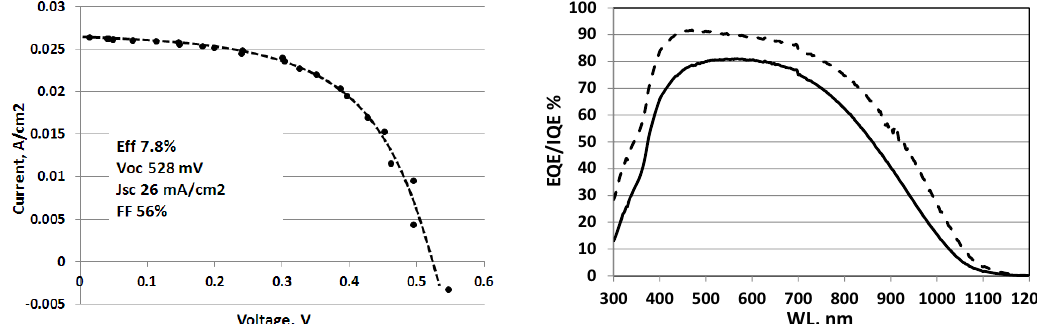
Fig. 5. (Left) Light I - V curve and (right) EQE (solid) and IQE (broken) of 7.8% efficient laser crystallised Si thin-film cell. presence of nitrogen contamination which can be nega- tively affecting the voltages. The best performing met- allised 7.8%-efficient cell on the O/C/O triple layer stack has V OC of 526 mV, similar to V OC of the cells on the oxide only but an improvement in cell antireflection prop- erties due to presence of a very thin SiC x layer on the front leads to a significant current gain, 26 mA/cm 2 ver- sus 24 mA/cm 2 for the cell on SiO x [11]. The light I - V curve of the best, 7.8% efficient cell is shown in Figure 5